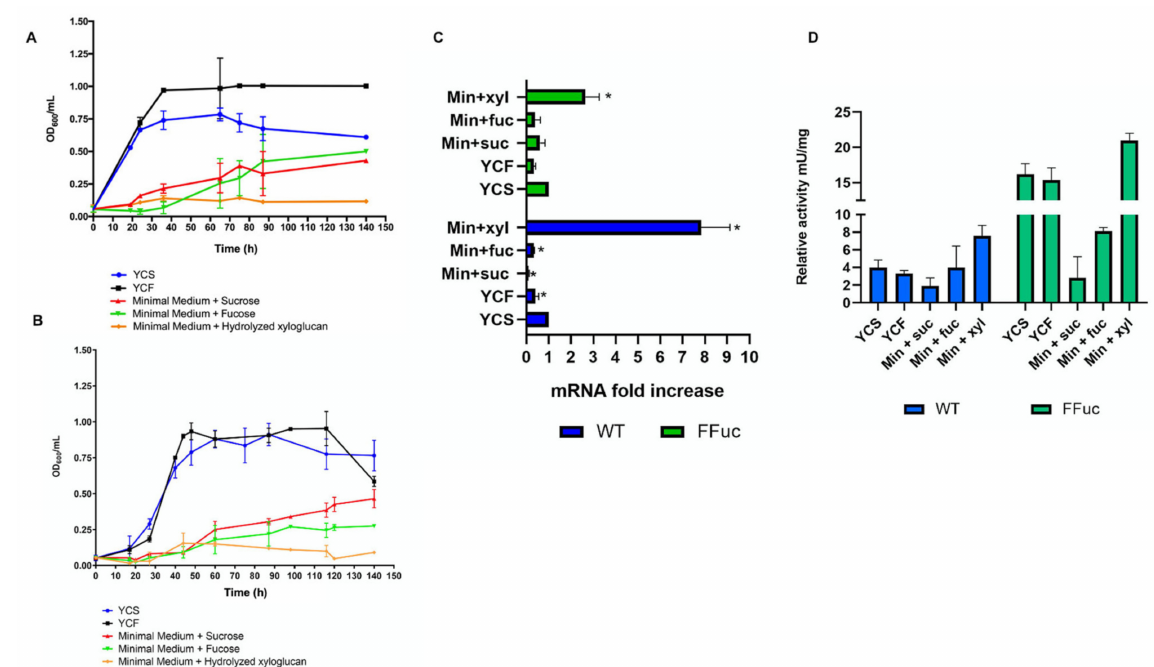
Figure 7. S. solfataricus strains growth with different carbon sources. ( A ) Representative growth curves of S. solfataricus WT strain in different media: YCS (blu), YCF (black), Minimal Medium + Sucrose (red), Minimal Medium + Fucose (green) and Minimal Medium + Hydrolyzed Xyloglucan (orange). Data are representative of three independent growth curves and are expressed as the mean ± SD. ( B ) Representative growth curves of S. solfataricus FFuc strain in different media: YCS (blu), YCF (black), Minimal Medium+ Sucrose (red), Minimal Medium + Fucose (green) and Minimal Medium + Hydrolyzed Xyloglucan (orange). ( C ) Real-time PCR of fucA and framefucA mRNA. The level of each mRNA was normalized against 16S (internal control). The mRNA amount in YCS was set to 1 and the other values were normalized accordingly. Data are representative of three measurements and are expressed as the mean ± SD. Statistical significance was performed using the two-tailed paired Student’s t test (* p < 0.05) and ANOVA Dunnett’s test ( p < 0.0001). ( D ) Activity assays on WT and FFuc S. solfataricus cellular extracts on 4NP- α - L -fucopyranoside. The relative activity of α - L -fucosidase is expressed as